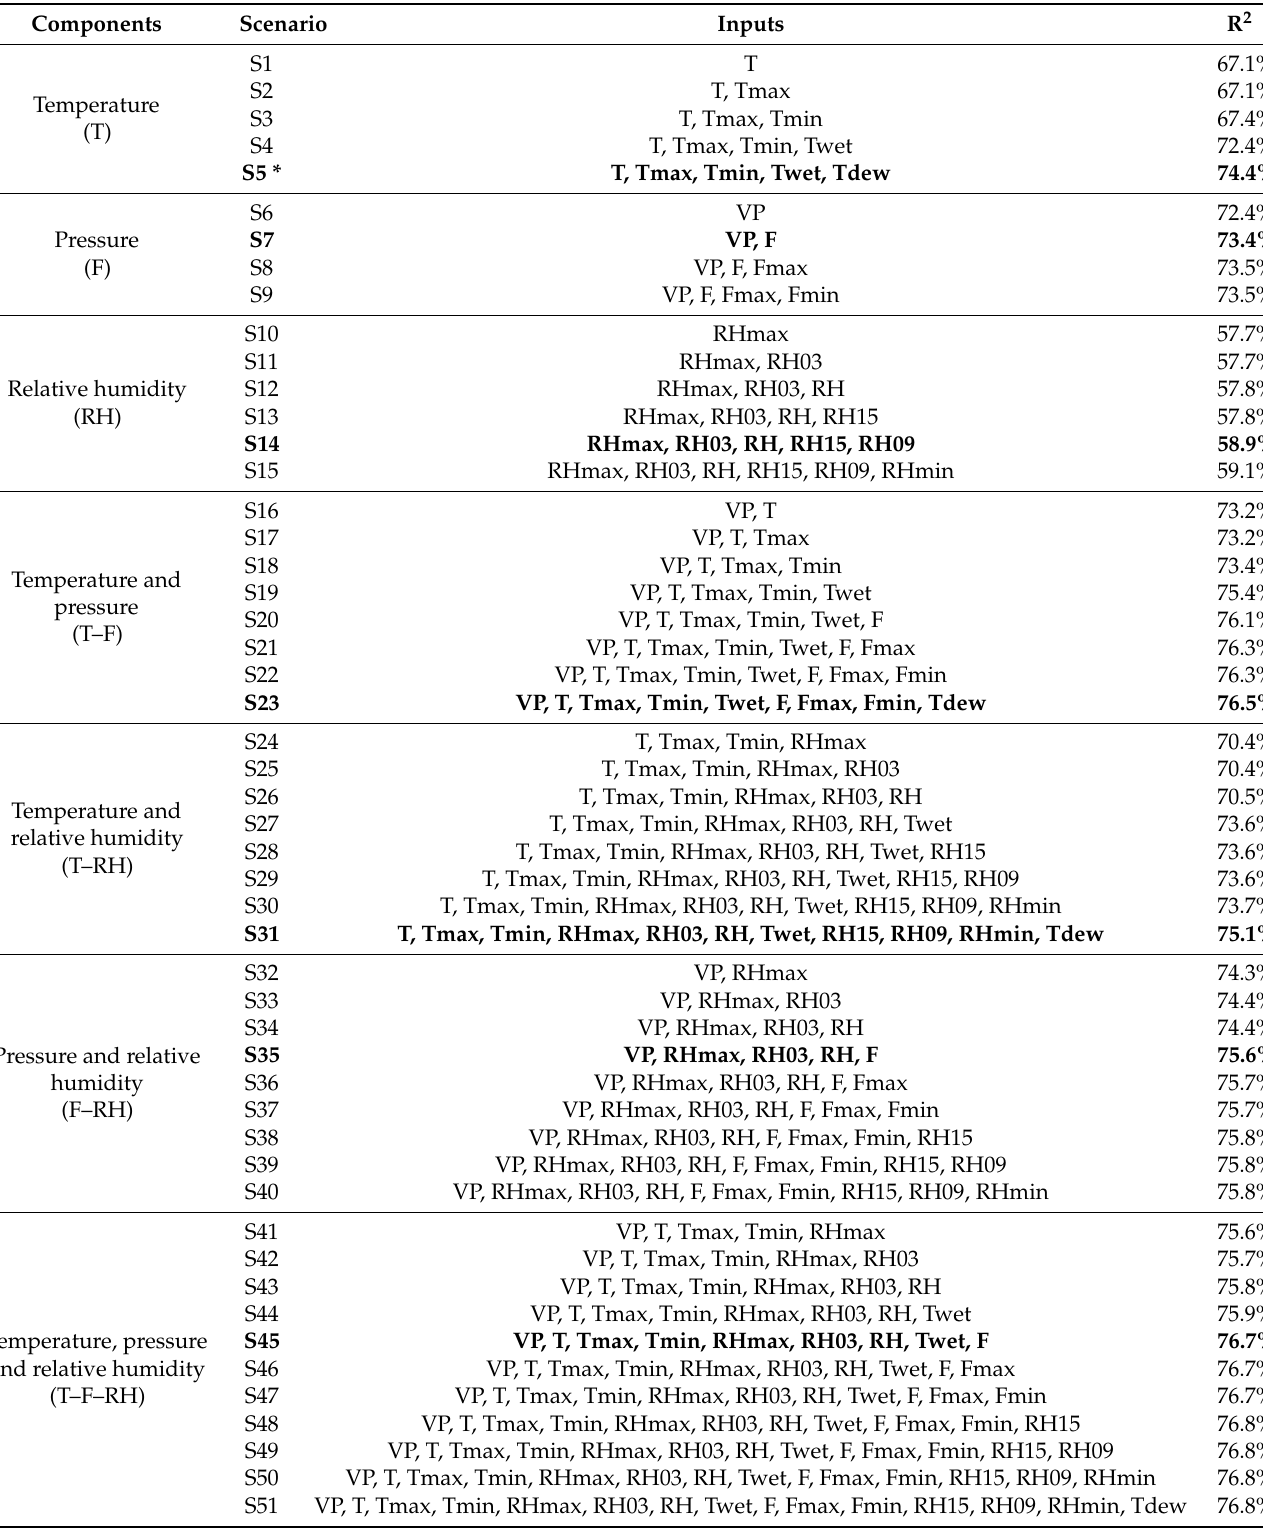
Table 2. Analyzing the input scenarios by multiple linear